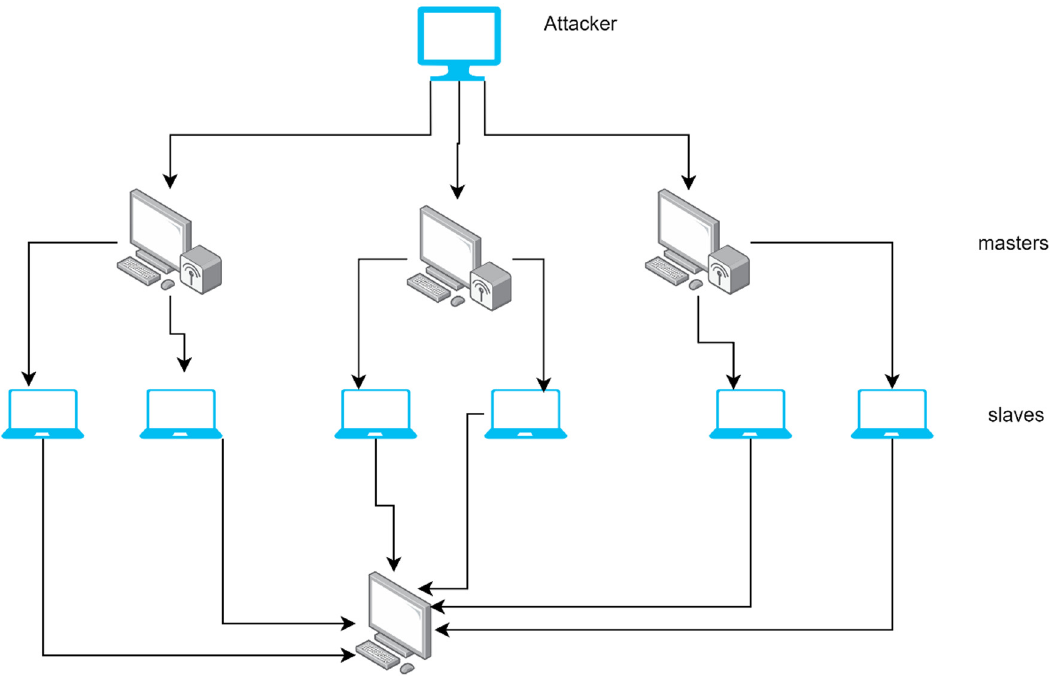
Figure 2: The structure of the DDoS attack [ 7 ]